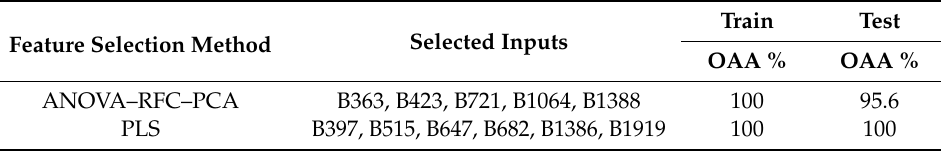
Table 2. A summary of the results obtained from the LDA in comparing of partial least squares (PLS) and ANOVA–RFC–PCA methods.